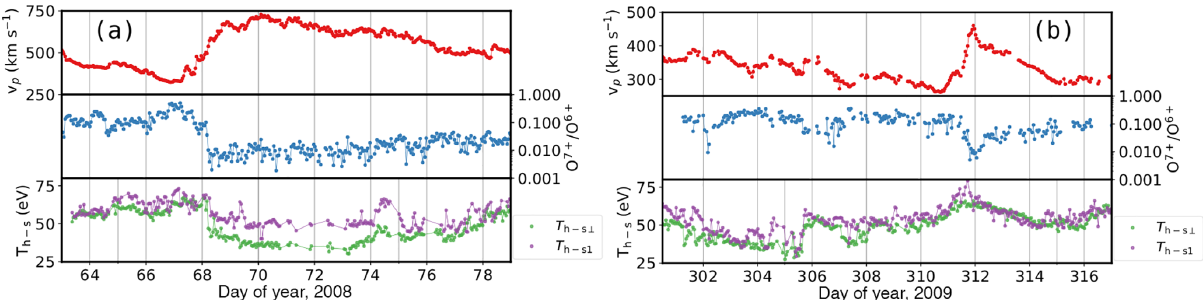
Figure 3. Time series data taken from portions of 2008 (a) and 2009 (b) . The top panels show solar wind proton speed as measured by the ACE spacecraft. The middle panels plot the oxygen charge state ratio O 7 + / O 6 + on a logarithmic scale. O 7 + / O 6 + varies counter to v p as is expected. The bottom panels plot the pair of proxy suprathermal temperatures T h–s ⊥ and T h–s1 . These vary synchronously, with T h–s1 tending to moderately higher values. We note that both temperatures appear to track well with O 7 + / O 6 + in case (a) , but in case (b) they appear to vary oppositely with it.